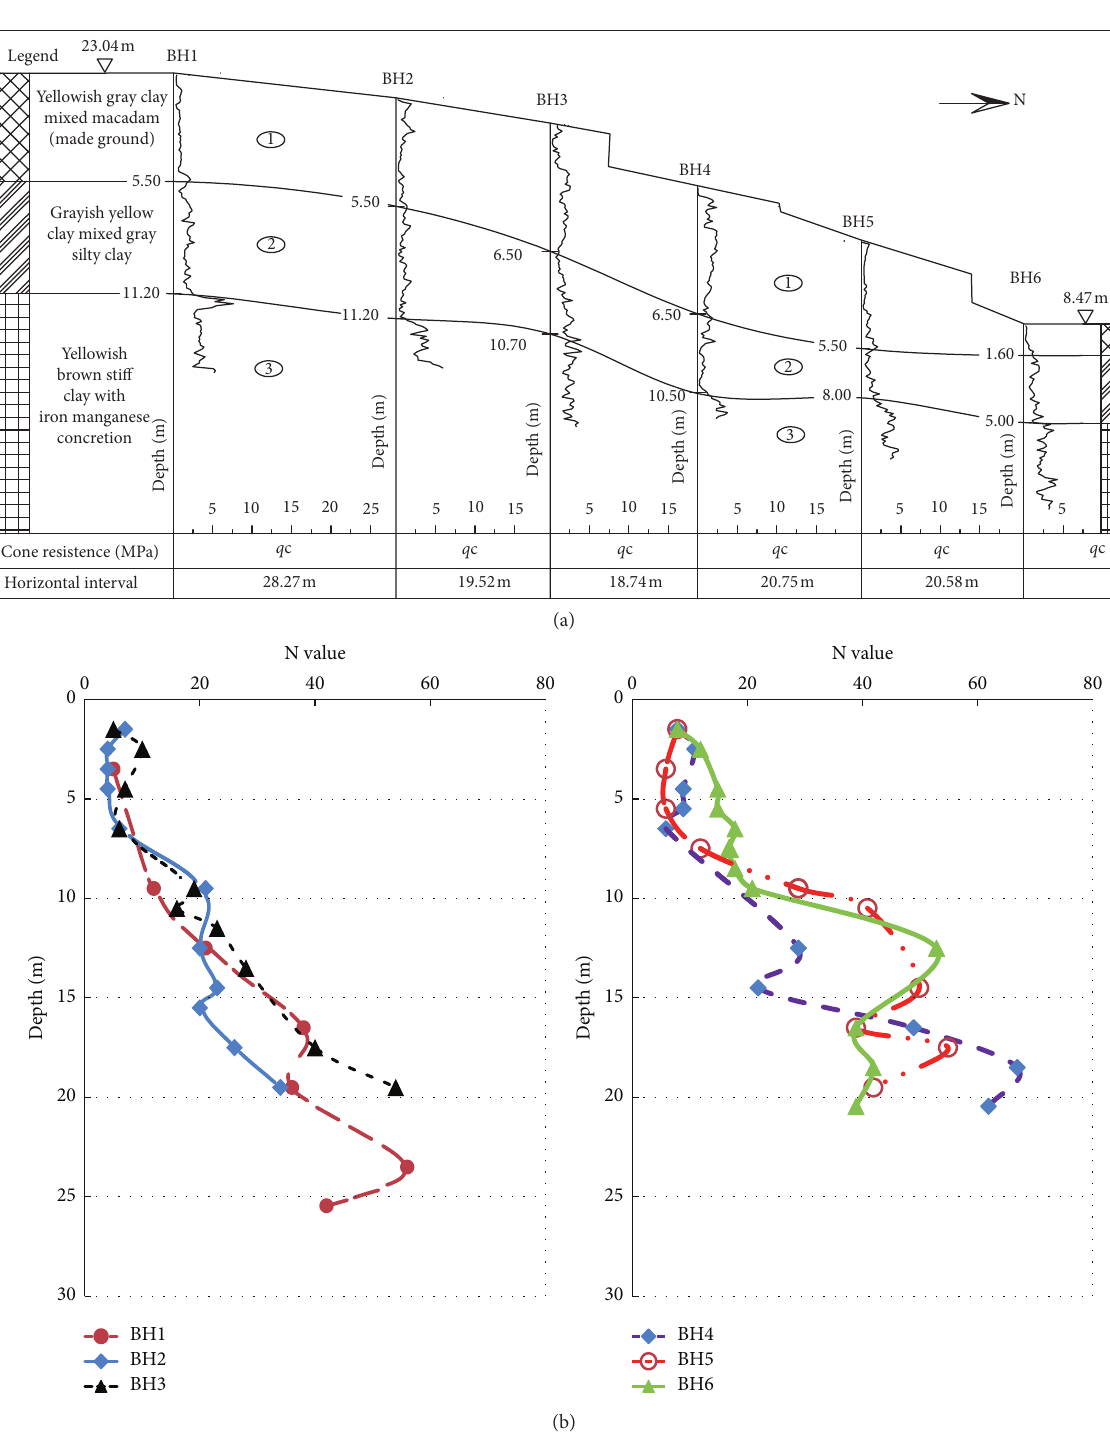
Figure 5: The results of the in situ tests: (a) CPT profiles (tip resistance); (b) the variation in SPT with borehole